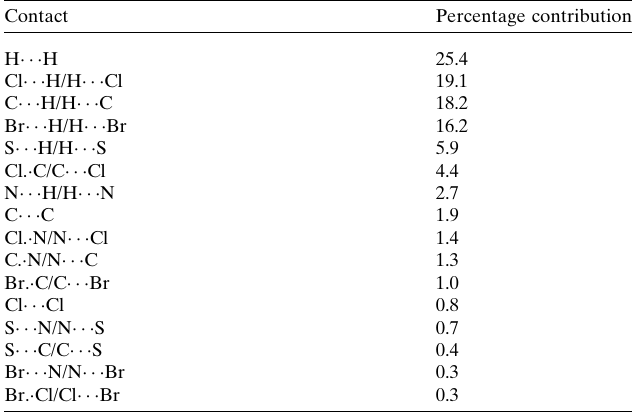
Table 3 Percentage contributions of interatomic contacts to the Hirshfeld surface for the title salt.